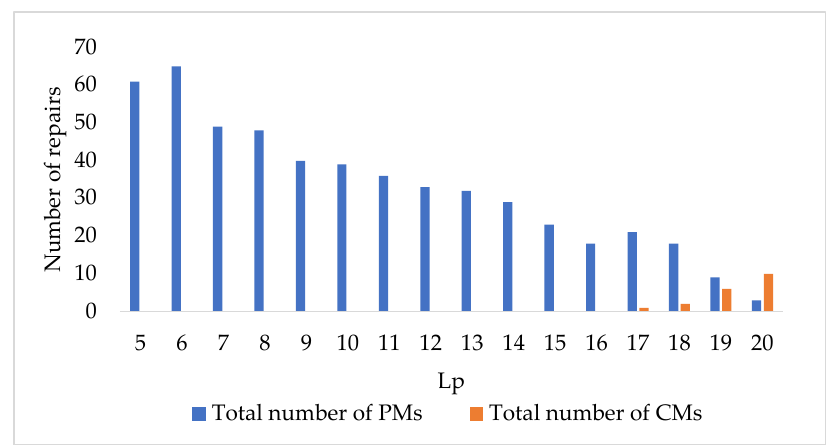
L corresponds to the number of repairs. Figure 3. When N = 19, L p p corresponds to the number of